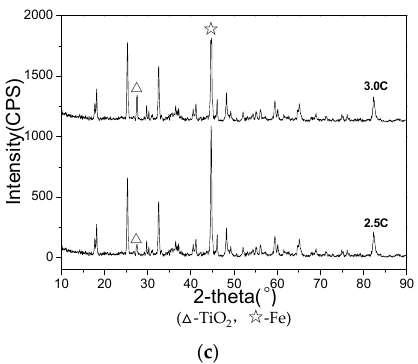
Figure 5. XRD patterns of magnetic products ( a ): reduction temperature 1150 °C , reduction time 1.5 h; ( b ): the sample number is 2.5C; and ( c ): samples 2.5C and 3.0C.